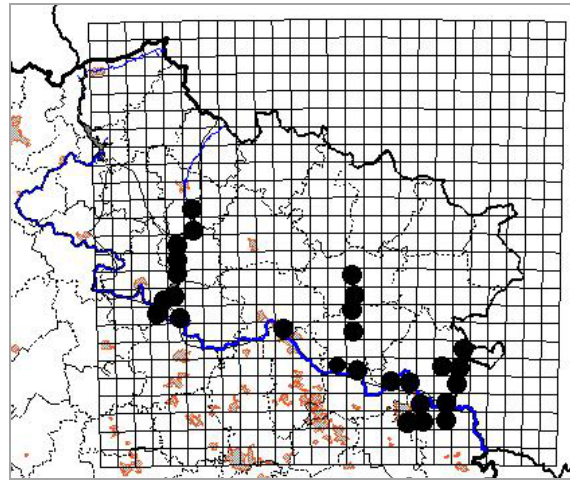
Fig. 29. The map of the distribution of Xanthium albinum (Widder.) H. Scholz. in the Starobilsk grass-meadow